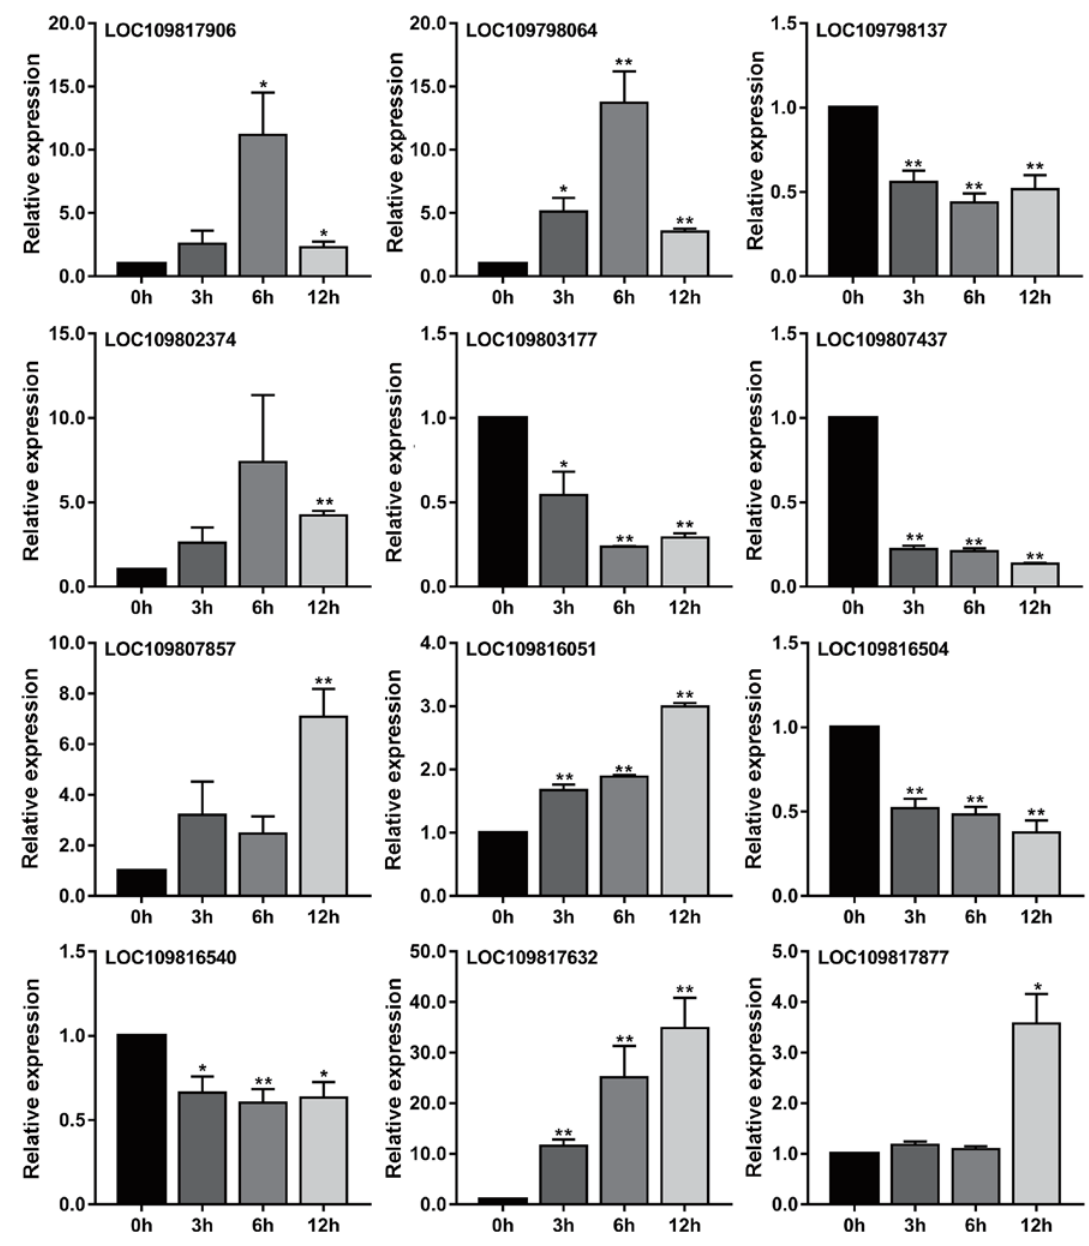
Figure 7. Relative expression levels of 12 core genes related to flavonoids and phenols in response to Al stress were determined by qRT-PCR. The levels of transcription of these genes in the roots of pigeonpea were studied at 0, 3, 6, and 12 h under Al stress. Each group had three biological replicates. **, p values < 0.01, and *, p values < 0.05, indicating significant di ff erence from corresponding controls, t -test of